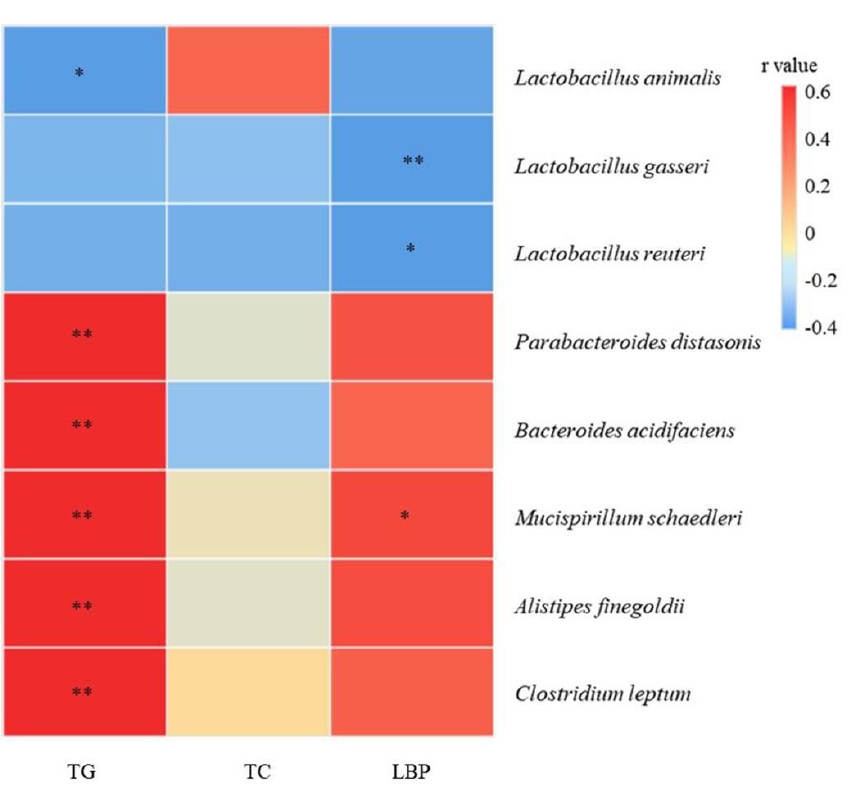
Figure A6. Spearman correlation analysis between bacterial species and serum biochemical indicators of TG, TC, and LBP in mice. TG, triglyceride. TC, total cholesterol. LBP, lipopolysaccharide-binding protein. n = 8 for each group. The r value represents the correlation coefficient. * p < 0.05, ** p < 0.01.